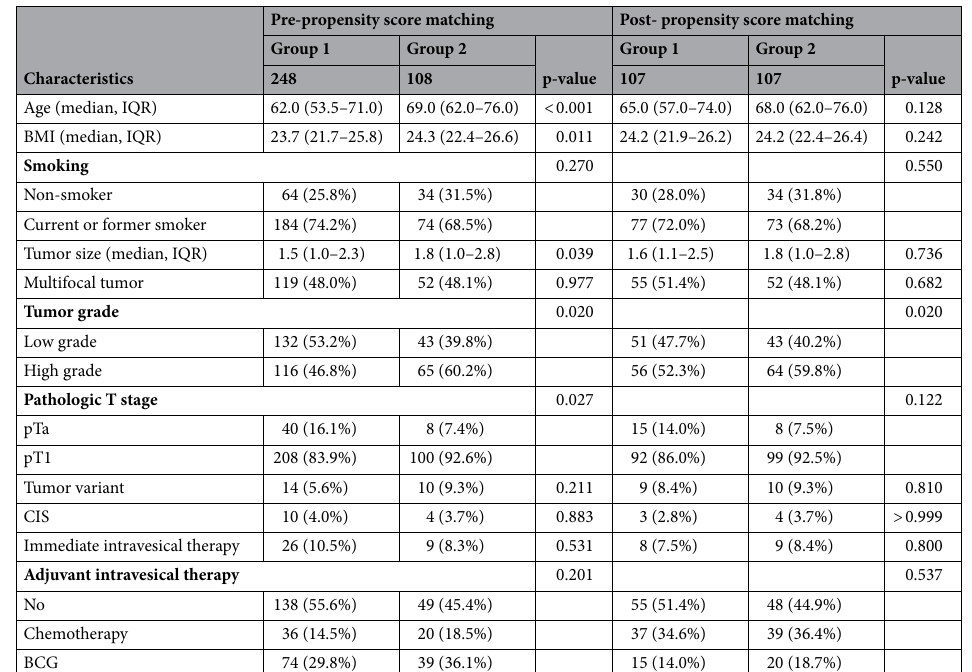
Table 1. Patients characteristics of group 1 (prostate volume ≤ 30 mL) and group 2 (prostate volume > 30 mL). IQR interquartile range, BMI body mass index, CIS carcinoma in situ, BCG bacillus